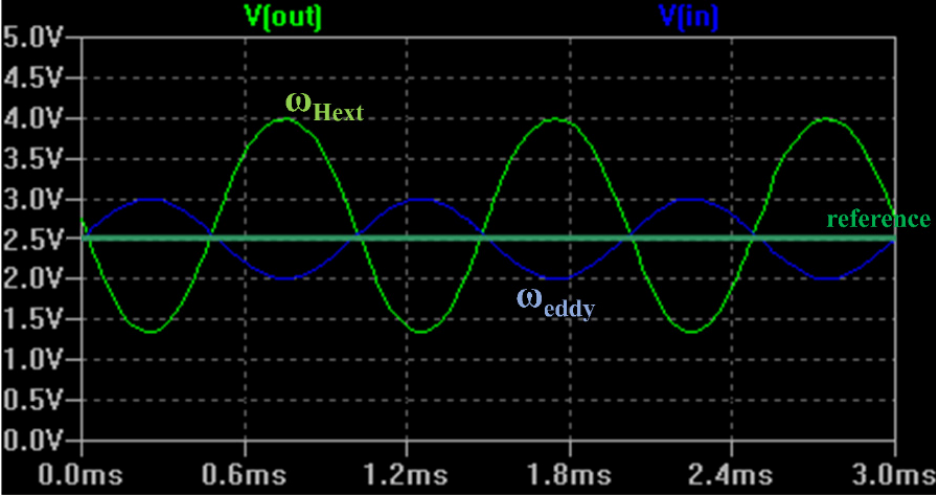
Figure 9. Simulation result of the sine waveform for the Colpitts oscillator and metal (clip). For the input voltage (V in : ω eddy ) of 1 V, the output voltage (V out : ω Hext ) is maintained as 2.6 V. If the oscillator starts operating, the steady-state oscillation voltage range is maintained from 0.0 V to 5.7 V between 40 ns and 200 ns under a sine waveform input voltage (V in : ω eddy ) of 1 V. However, if coupling occurs between the coil and the metal (clip) of the oscillator, the output voltage (V out : ω Hext ) is maintained at 2.6 V ( ω metal - detection ), as shown in Figure